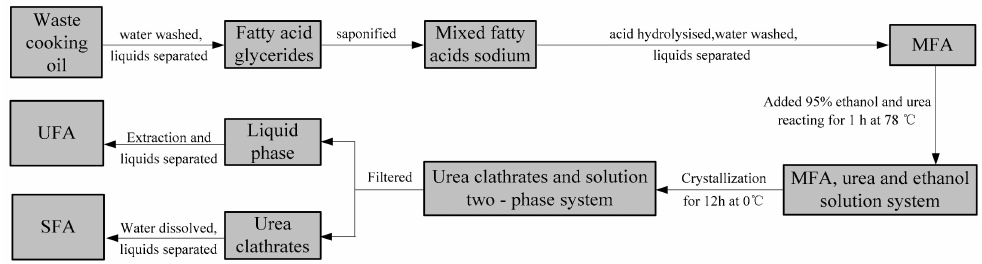
Figure 2. The preparation process of collector SFA and UFA from waste cooking